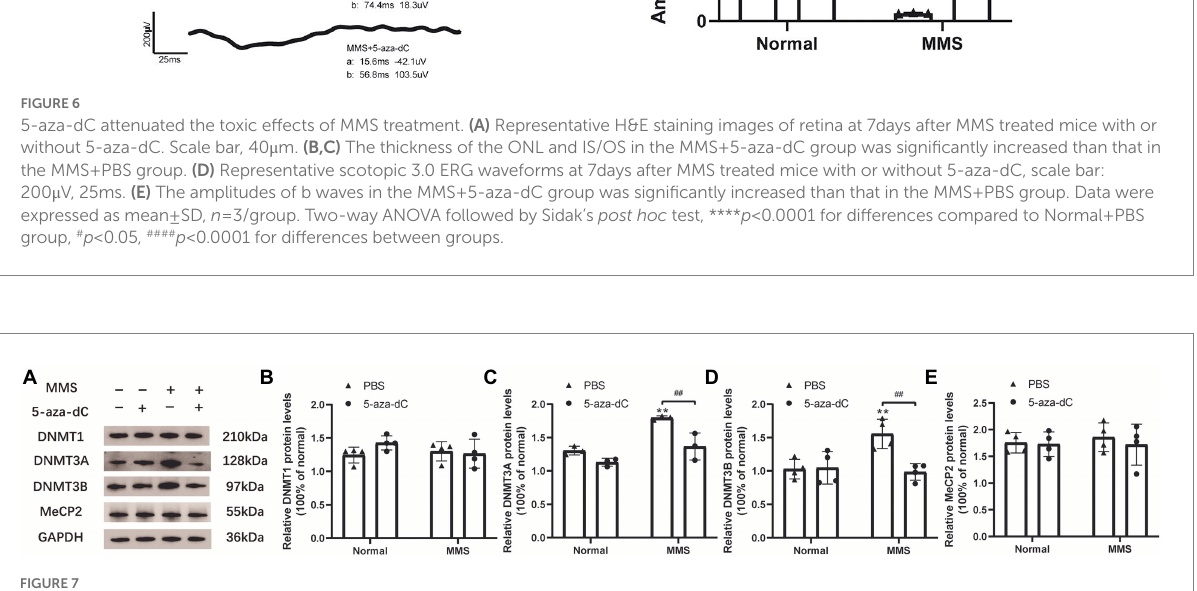
polymers could restrain glycolysis by binding and inhibiting hexokinase in mitochondria, leading to cell death (Andrabi et al., 2014). Therefore, the alkylating agents induced RP animal